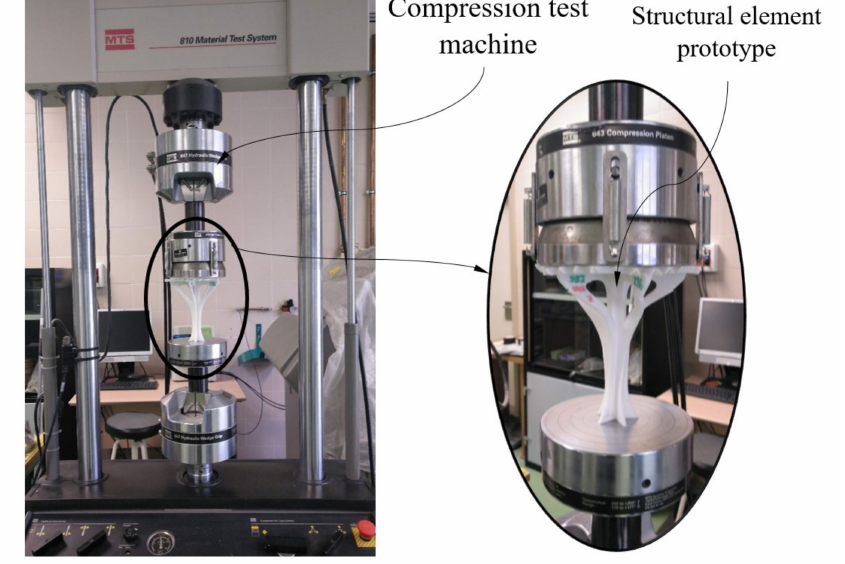
Figure 6. Uniaxial compression experimental test for the part under